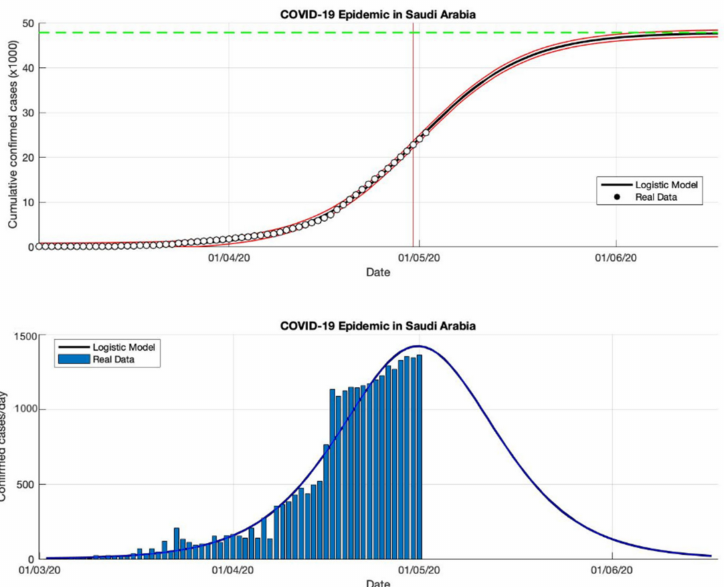
Figure 8. In the above figure, the prediction results of the logistic growth model for cumulative infected cases are compared with the actual data, while the two red lines between the black lines represent a prediction error limit of about 5%. The dashed green line predicts the total size of infected cases in the final phase of the epidemic. The red line intersects the cumulative case curve to predict the turning point or peak point of the epidemic (this line is parallel to the top of the curve from the below figure). In the below figure, the prediction results of this model for daily infected cases in